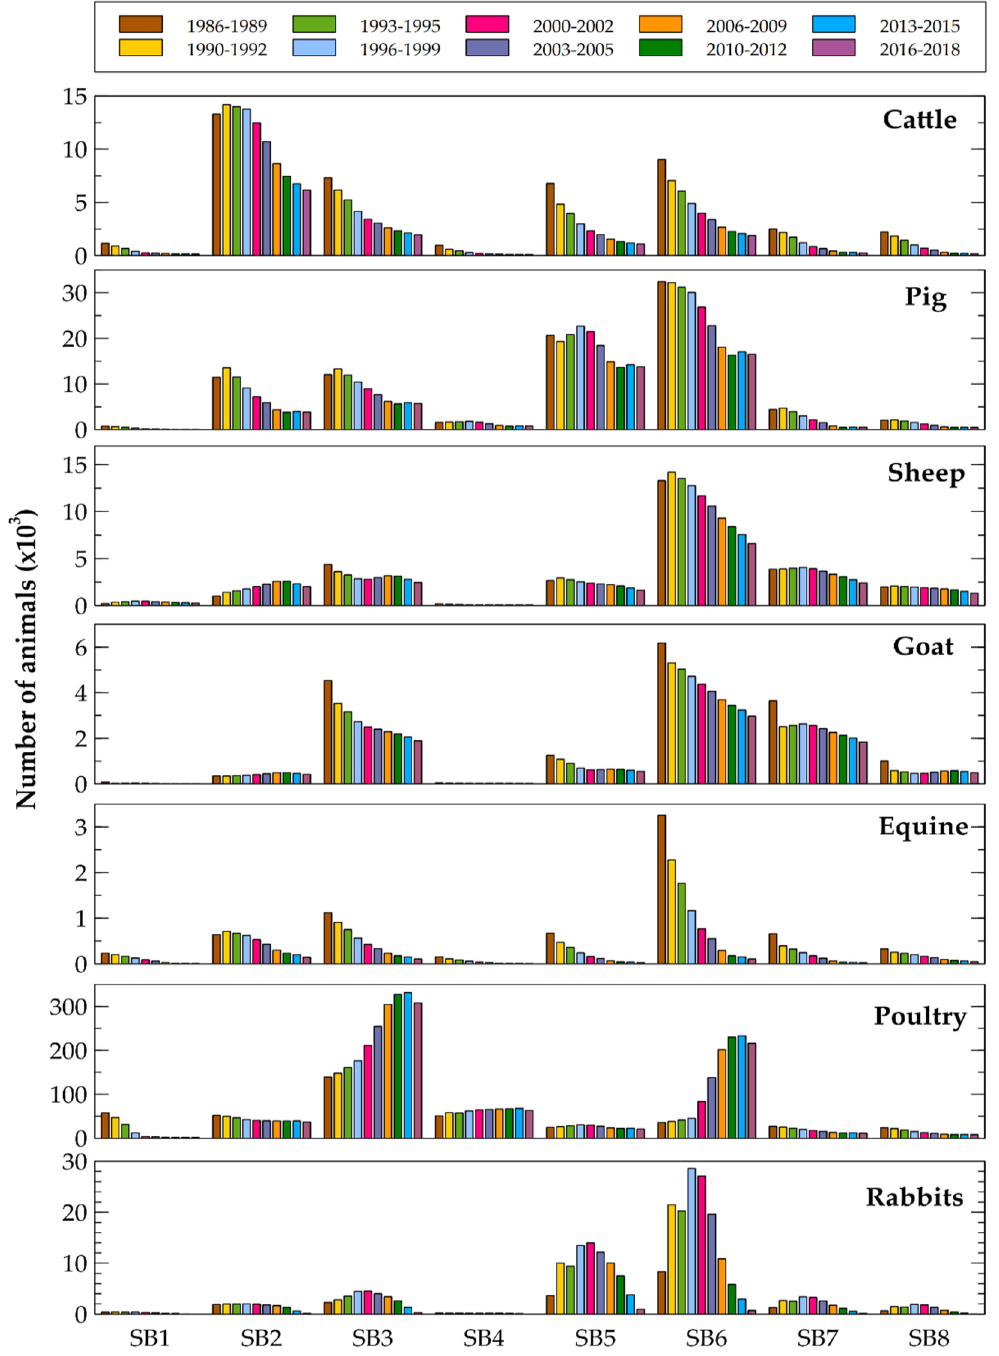
Figure 12. Number of animals in each sub-basin in Low Mondego.